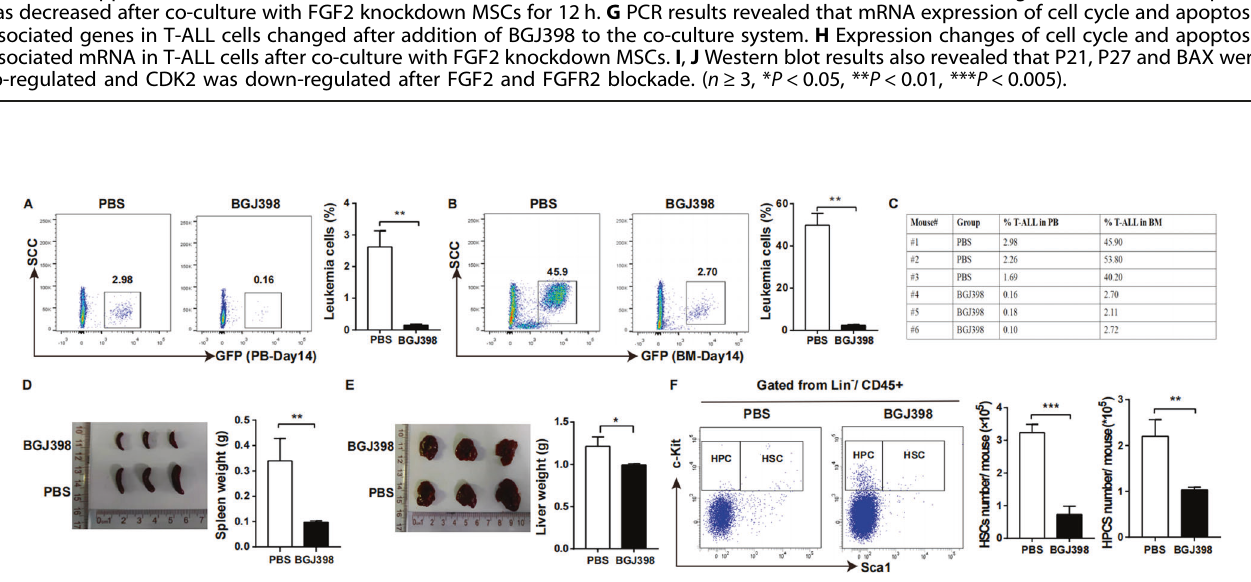
Fig. 6 The progression of T-ALL was signi fi cantly delayed after FGF2/FGFR2 blockade in vivo. A The engraftments of T-ALL cells in PB were signi fi cantly decreased on day14 after model establishment when the mice were injected intraperitoneally with BGJ398. B The engraftments of T-ALL cells in BM were similarly prominently decreased on day14 after model establishment when FGF2 and FGFR2 combination was disrupted. C The dynamic monitoring of the proportion of T-ALL cells in PB and BM were summarised. D The size and weight of spleen from FGF2/FGFR2 blockade mice were reduced on day14 after model establishment. E The size and weight of liver from FGF2/FGFR2 blockade mice was shrunk on day14 after model establishment. F To intuitively understand the changes of the number of normal HSCs and HPCs in BM of T-ALL after FGF2/FGFR2 blockade, FACS was used and results showed that both number of them were decreased. ( n ≥ 3, * P <0.05, ** P <0.01, *** P <0.005).